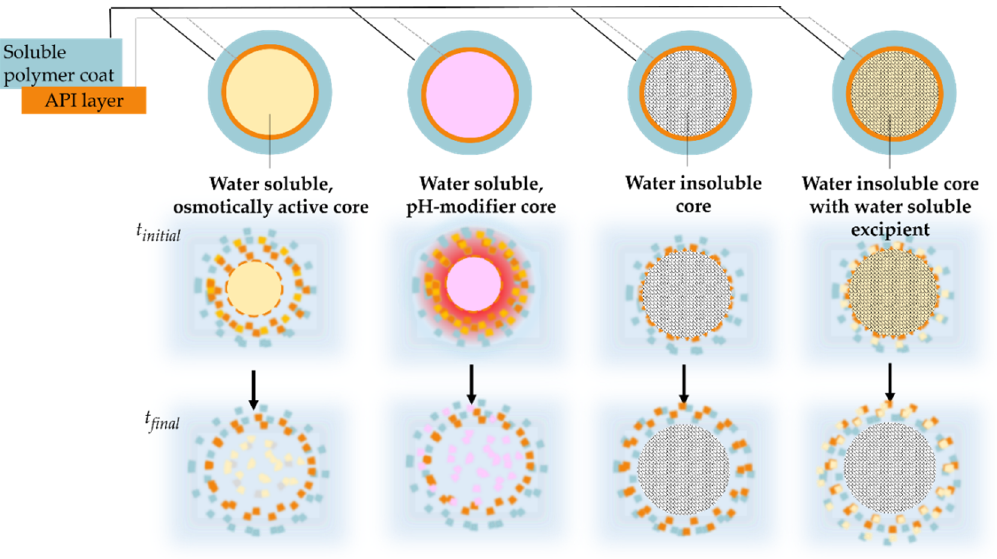
Figure 10. Schematic illustration of drug release from enteric-coated pellets (medium: high pH).